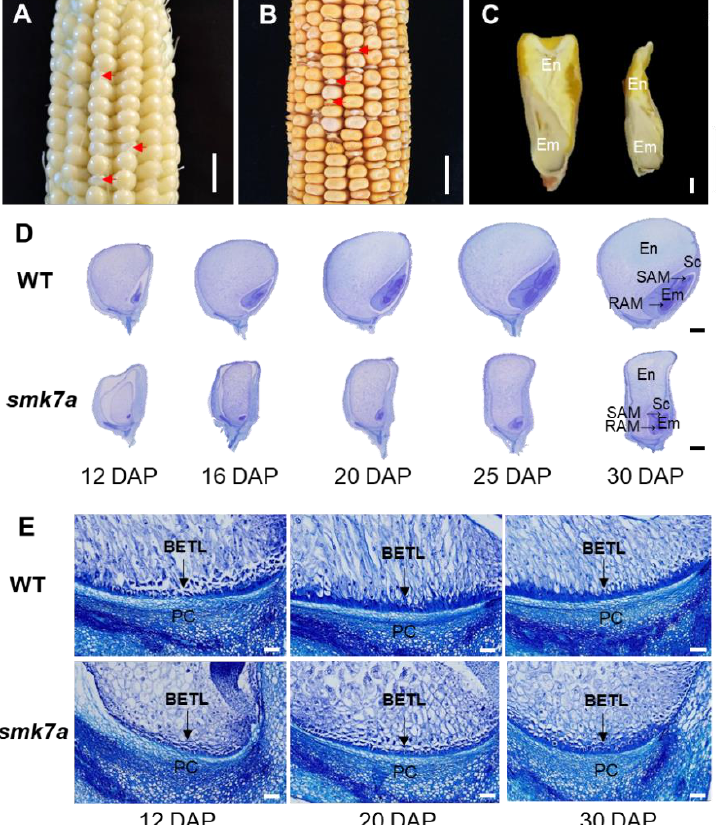
Figure 1. Phenotype features of the maize smk7a mutant. ( A ) An F 2 ear of smk7a /WT at 12 DAP. The arrows indicate three randomly selected mutant kernels. The scale bar is 1 cm. ( B ) A mature F 2 ear of smk7a /WT. The arrows indicate three randomly selected mutant kernels. The scale bar is 1 cm. ( C ) Examples of mature WT and smk7a kernels from the segregated F 2 . The scale bar is 1 mm. ( D ) Light microscopy analysis of immature kernels from the WT and smk7a collected at 12, 16, 20, 25, and 30 DAP. The scale bar is 1 mm. En, endosperm; Em, embryo; SAM, shoot apical meristem; RAM, root apical meristem. ( E ) Light microscopy analysis of BETL cells of the WT and smk7a kernels collected at 12, 20, and 30 DAP. DAP, days after pollination. BETL, Basal endosperm transfer layer; PC, placenta. The scale bar is 200 μm.